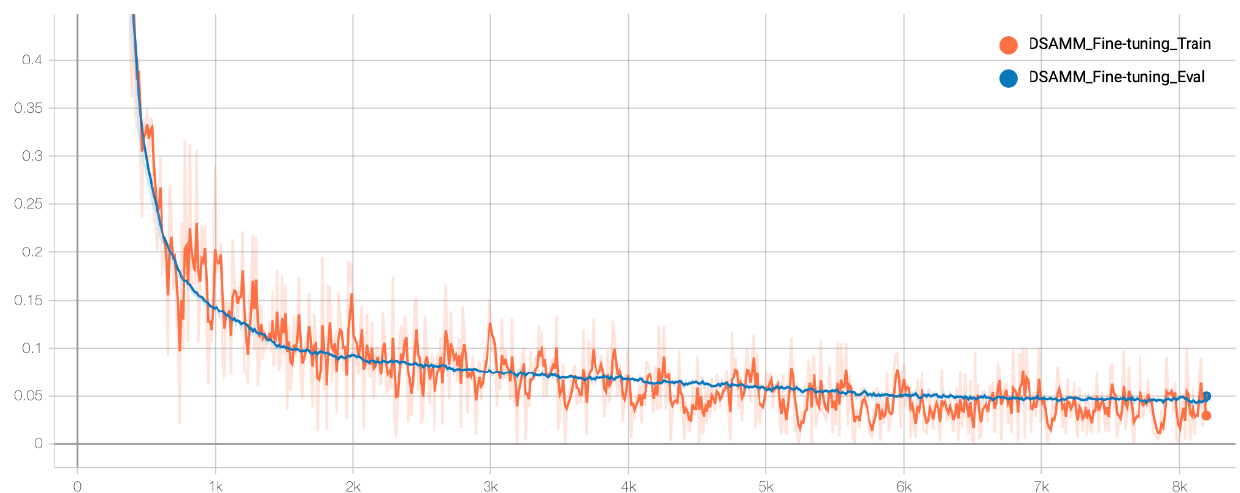
Figure 5. Training loss-gradient curve overlaid with validation loss-gradient curve of the DSAMM,